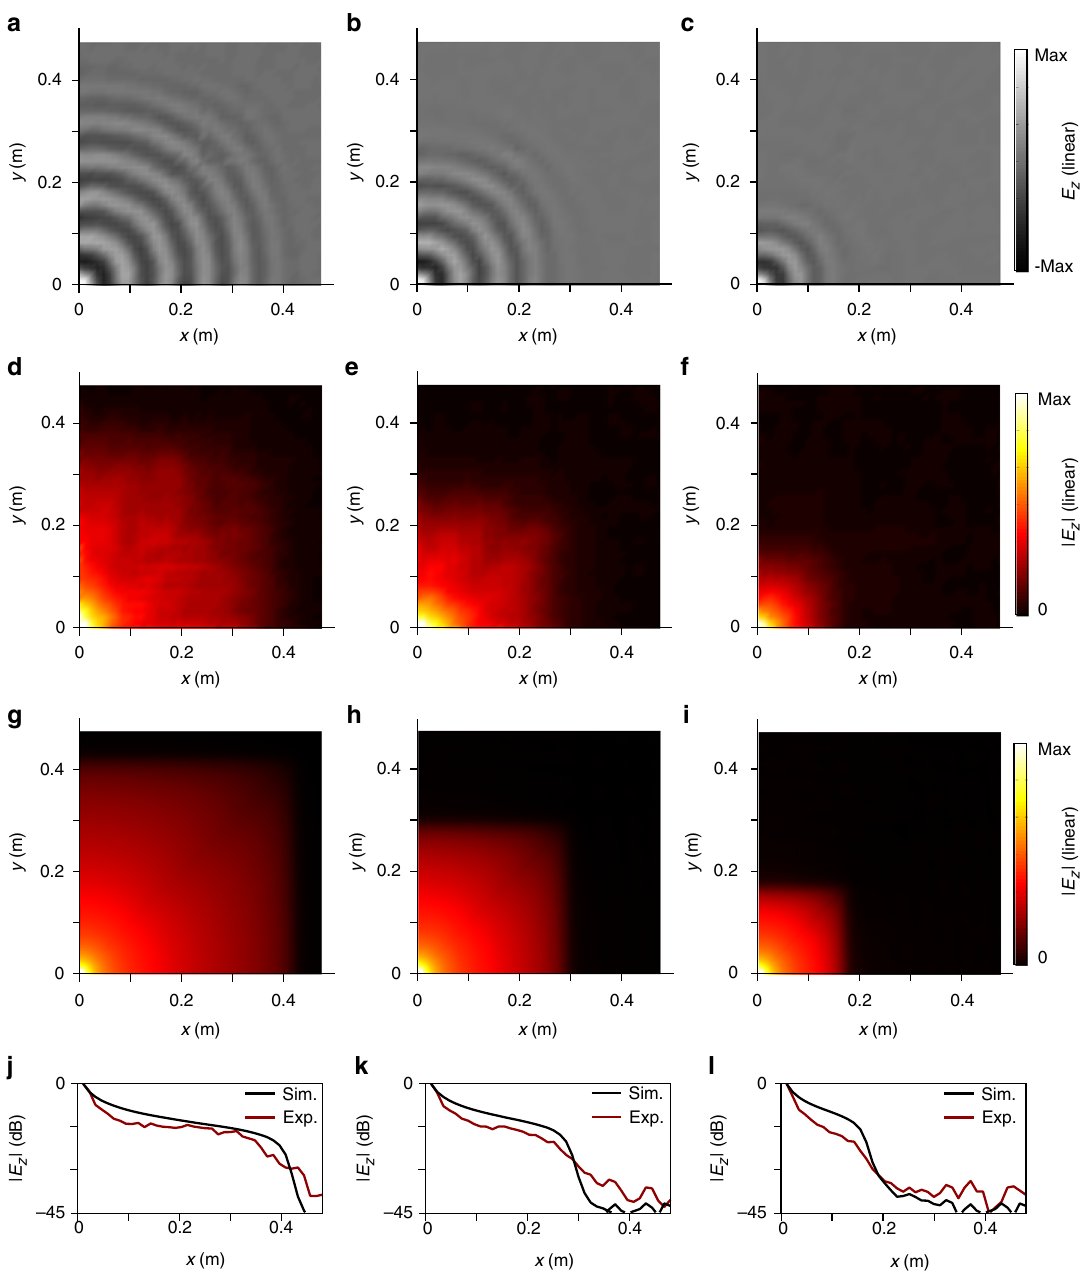
Fig. 6 Experimental results and analysis. a – c Instantaneous snapshots of the electric fi elds measured at 2.3, 2.4, and 2.5 GHz, respectively. All the measured data are normalized by the amplitude and phase of the electric fi eld measured at one unit cell nearest to the source monopole. d – f Amplitudes of the electric fi elds measured at the same frequencies. For comparison, g – i show the corresponding simulations under the same conditions. j – l Comparison between the measured and simulated intensity drops in dB scale along the x axis at y =